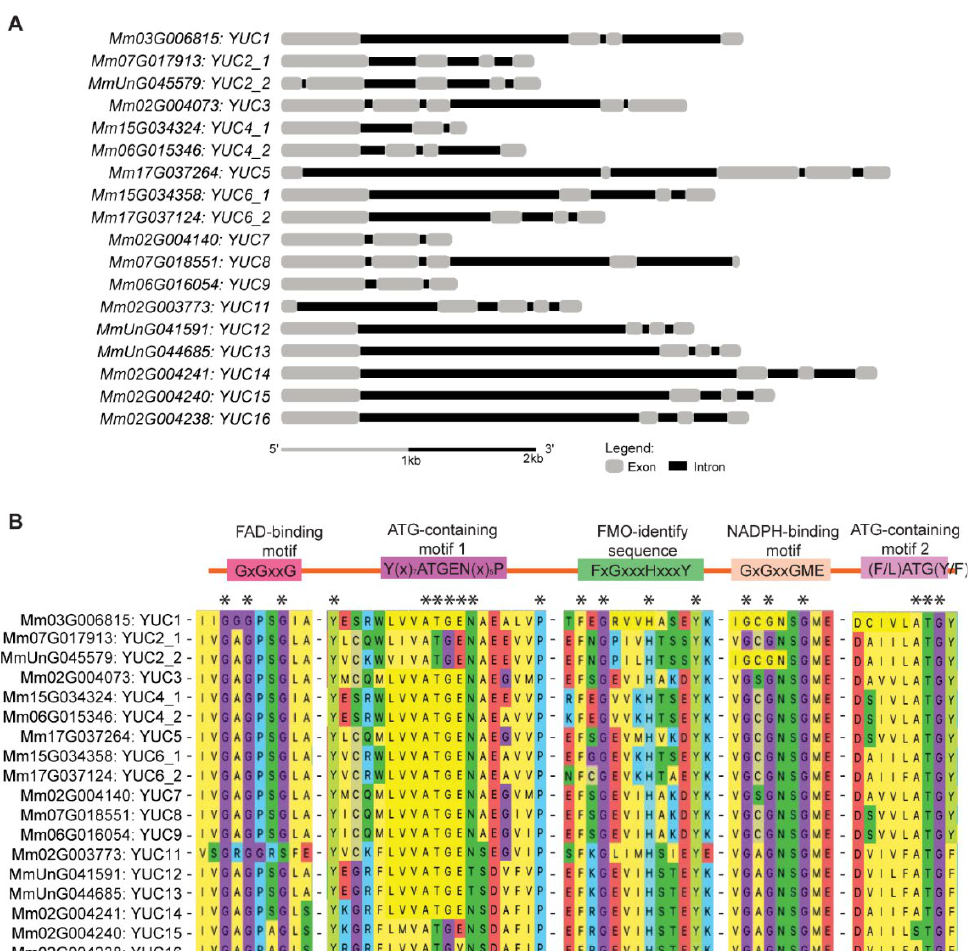
Figure 1. MmYUC members identified in M. micrantha genome. ( A ) Structure of MmYUC genes. The exons and introns are represented by grey boxes and black lines, respectively. ( B ) Alignment of conserved domains in MmYUCs. Stars (*) indicate the conserved amino acids in the motif.